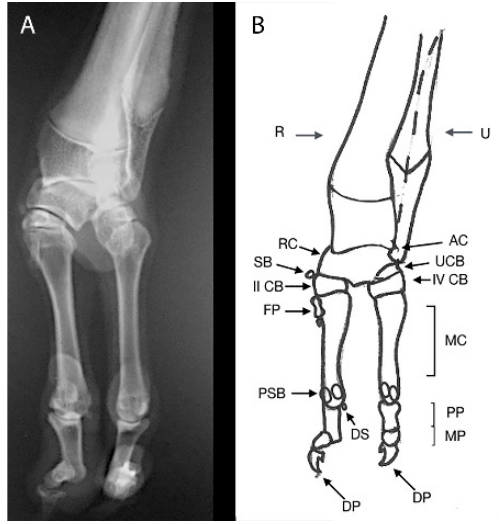
Figure 10. Case 4. Dorsopalmar radiograph ( A ) and drawing scheme ( B ) of the right forelimbs malformation. R: Radius; U: Ulna; RC: Radial Carpal Bone; UCB: ulnar Carpal Bone; AC: Accessory Bone; SB: Sesamoid Bone; CB: Carpal Bone; MC: Metacarpal Bone; PP: Proximal Phalange; MP: Middle Phalange; DP: Distal Phalange; DS: Dorsal sesamoid; PSB: Proximal Sesamoid Bone.